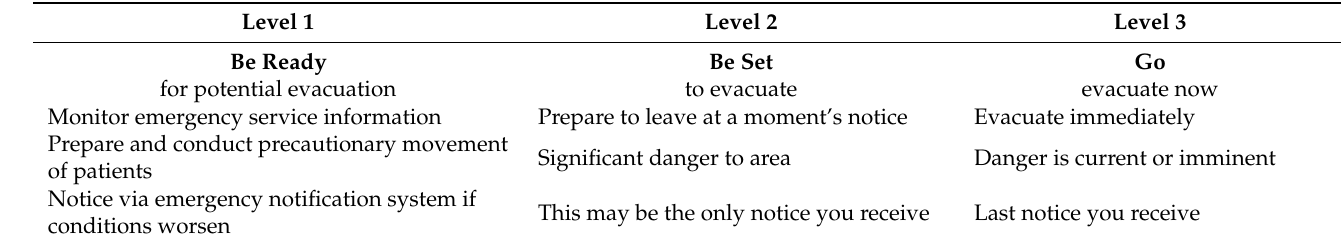
Table 1. Levels of evacuation